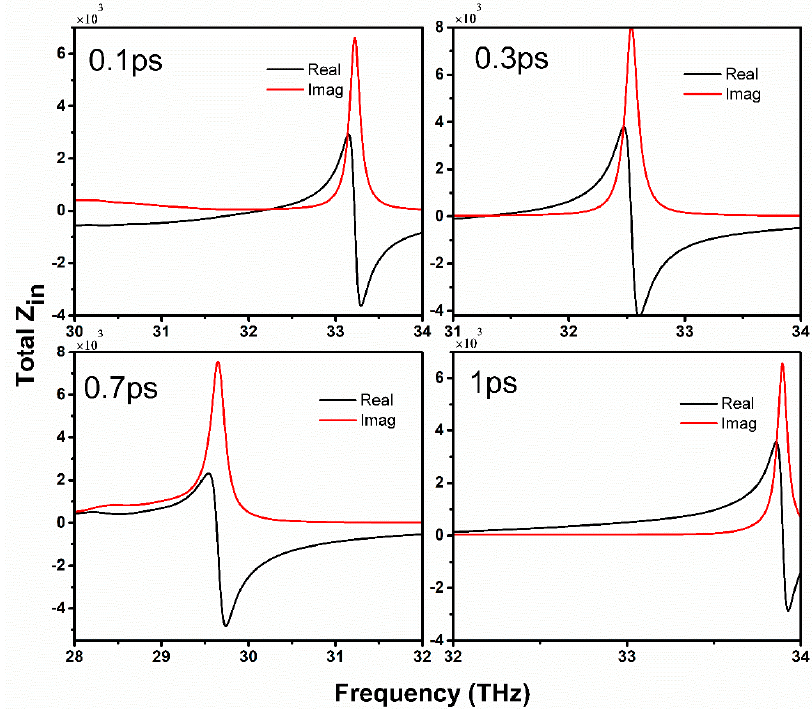
Figure 11. The real and imaginary input impedance at four di ff erent characteristic modes.